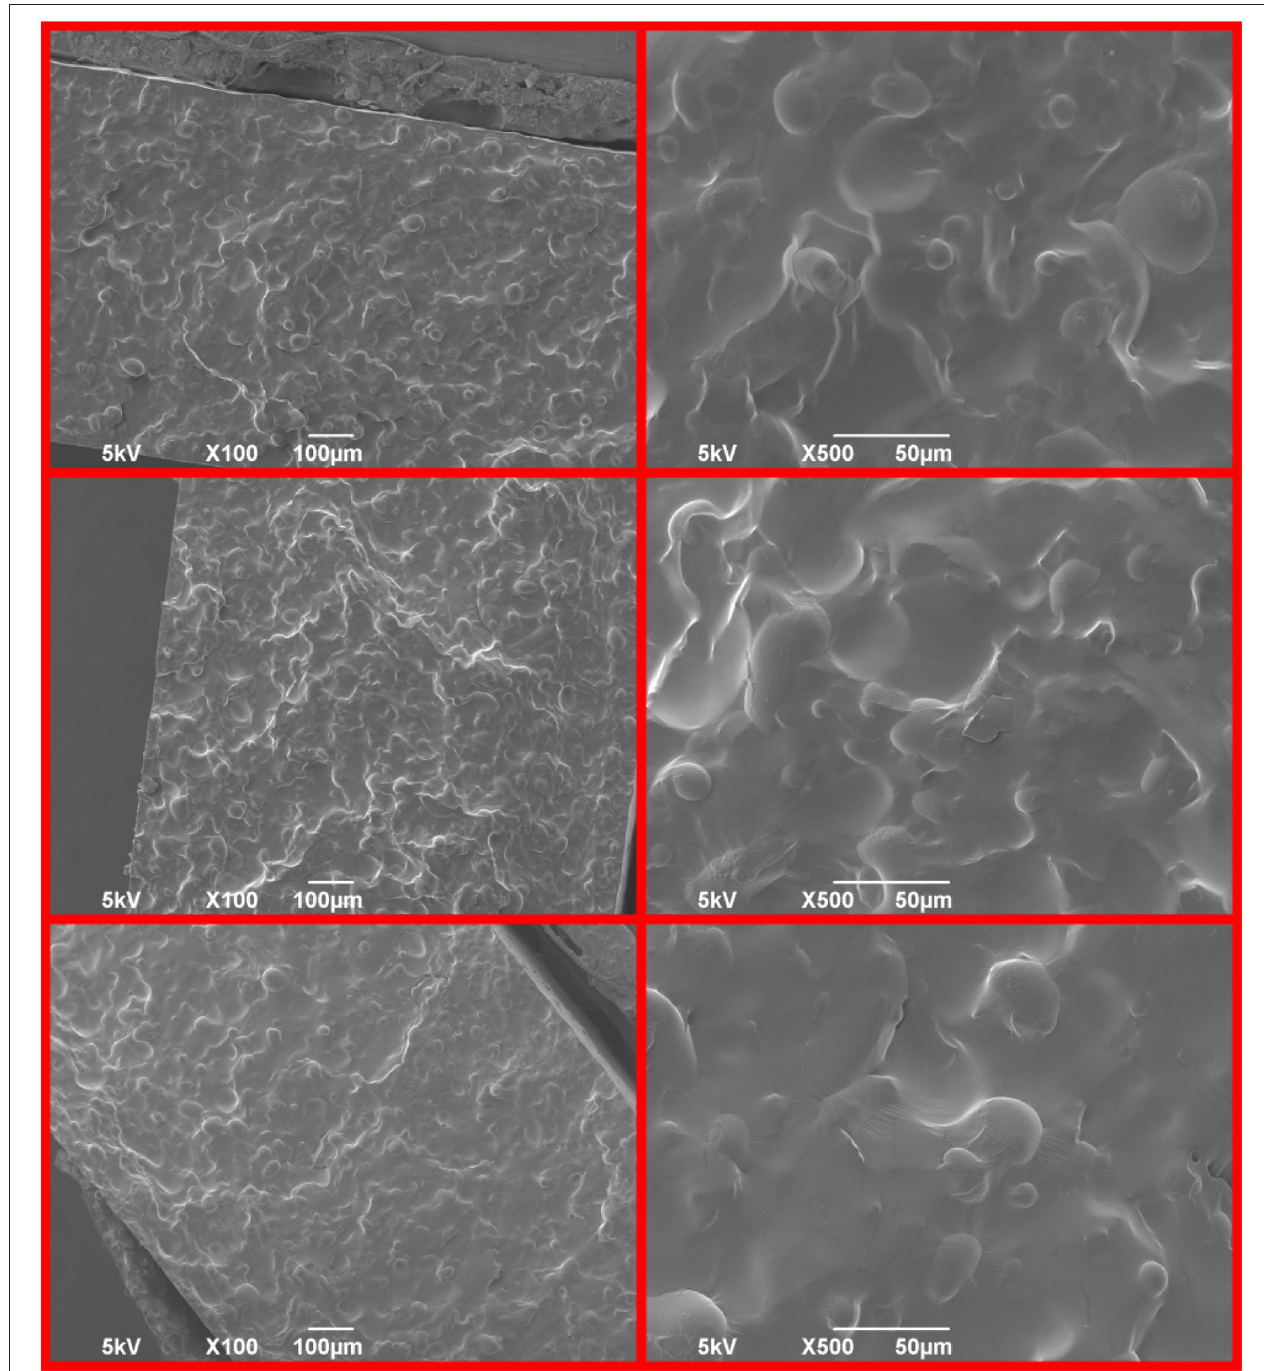
FIGURE 2 | Different levels of dispersion between the medium and the potato starch particles. Top row-E43PPS50. Middle row-E43PS50. Bottom row-E43PS50W.